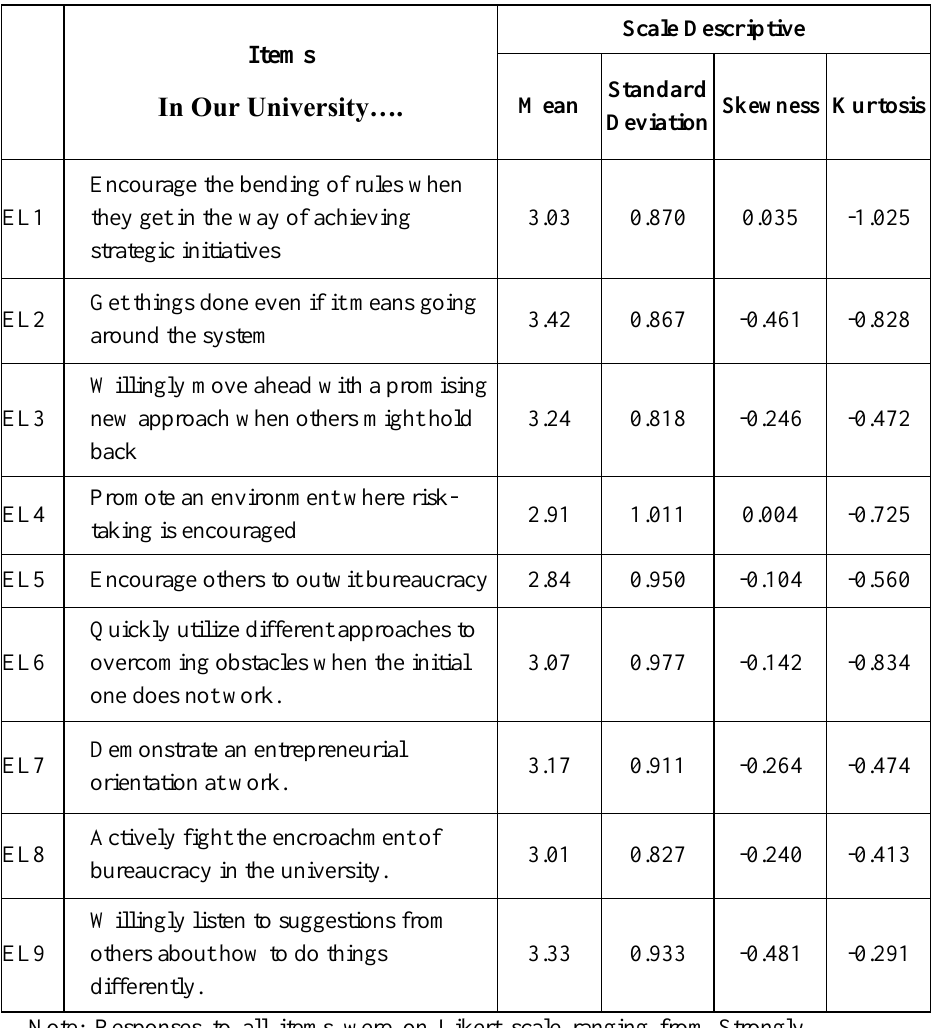
Table 4: Measures of Entrepreneurial Leadership Behavior Items In Our